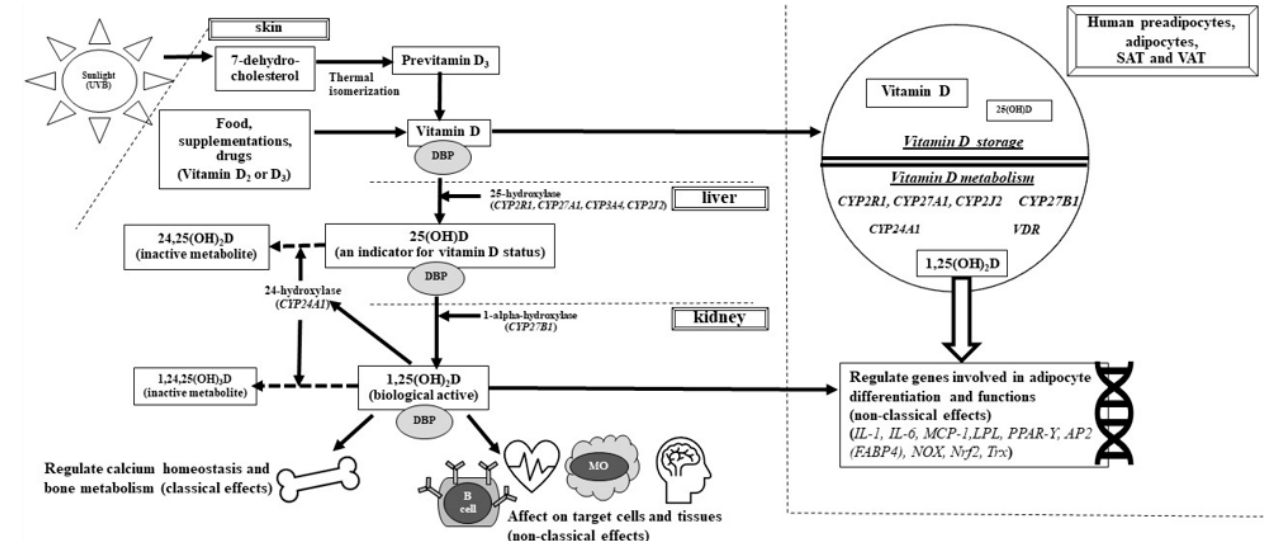
Figure 1. Vitamin D metabolism and functions . Vitamin D (synthesis from skin and intake from food, supplementation, and drugs) are activated by 2 hydroxylation processes; 25-hydroxylation in the liver and 1-alpha-hydroxylation in the D]. 24-hydroxylase inactivates both 1,25(OH) D and 25(OH)D to kidneys, and then becomes an active form [1,25(OH) 2 2 inactive metabolites. DBP facilitates delivering vitamin D and its metabolites to various target cells and tissues. Many cells and tissues, including human preadipocytes, adipocytes, SAT and VAT express vitamin D metabolizing enzymes and can activate 25(OH) D to an active form. 1,25(OH) D also regulates many genes involved in adipocyte differentiation and 2 functions. D: D or D , DBP: vitamin D binding protein, 25(OH)D: 25 - hydroxyvitamin D, 1,25(OH) D: 1,25 2 3 2 dihydroxyvitamin D, VDR : vitamin D receptor IL: interleukin, MCP - 1 : monocyte chemoattractant protein 1, LPL : lipoprotein lipase, PPAR - γ : peroxisome proliferator - activated receptor γ , AP2 :adipocyte - binding protein 2, FABP4 : fatty acid - binding protein 4, NOX: NADPH oxidase, Nrf2 : transcription nuclear factor 2, Trx: thioredoxin, SAT: subcutaneous adipose tissue, VAT: visceral adipose